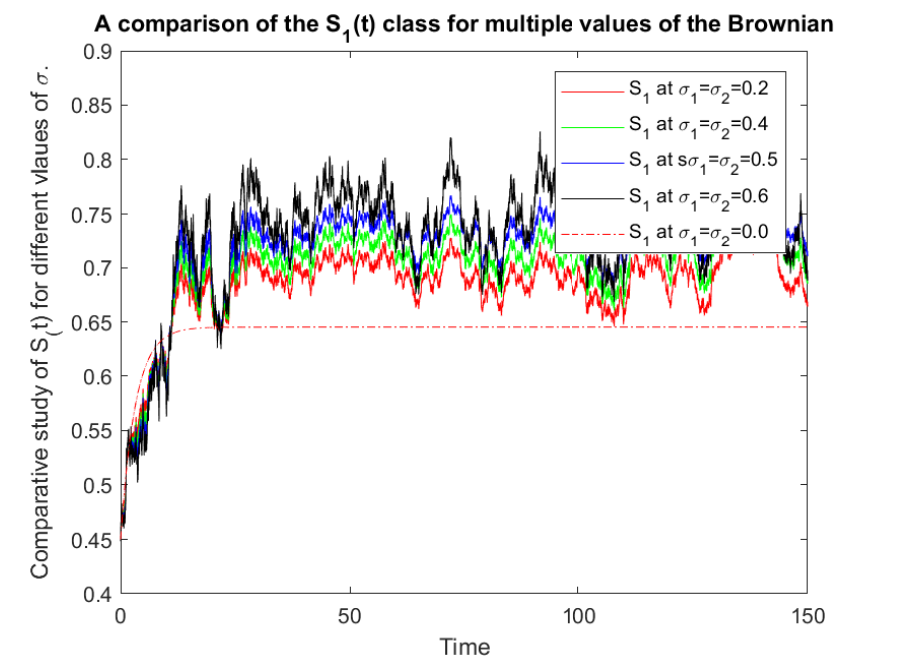
Figure 6. Comparative analysis of S 1 ( t ) for σ 1 = σ 2 = 0.2,0.4,0.5,0.6,0.0.